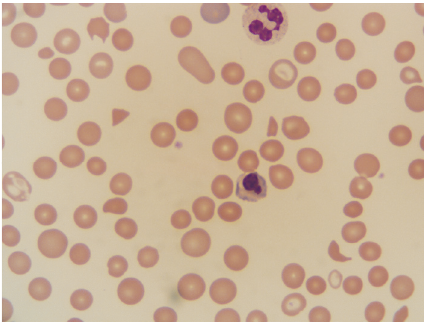
Figure 2: Renal biopsy of Case B showed evidence of a thrombotic microangiopathic